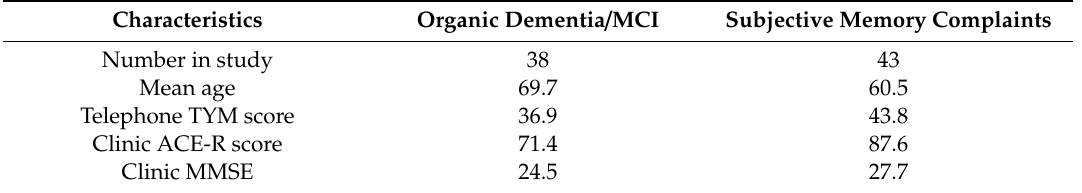
Table 3. Telephone TYM scores, clinic ACE-R (Addenbrooke’s Cognitive Examination Revised) and clinic MMSE scores in patients with organic dementia or MCI and no organic